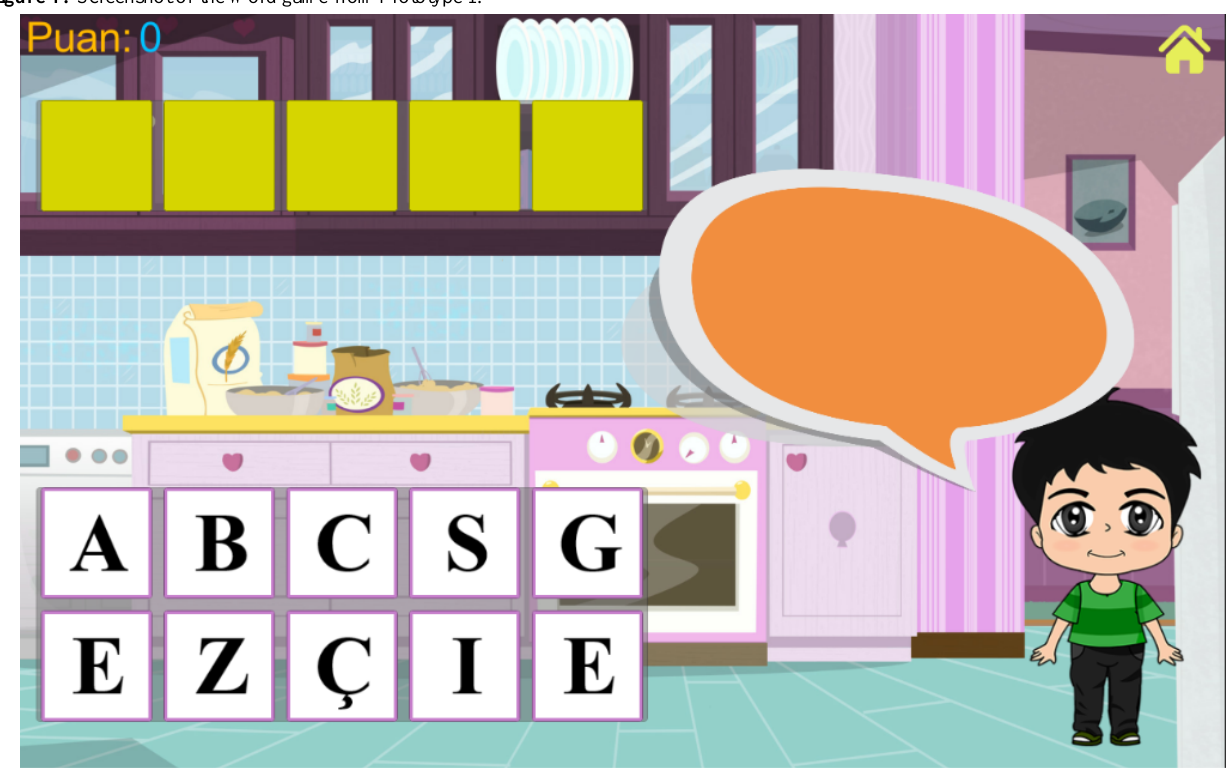
Figure 1. Screenshot of the Word game from Prototype I.